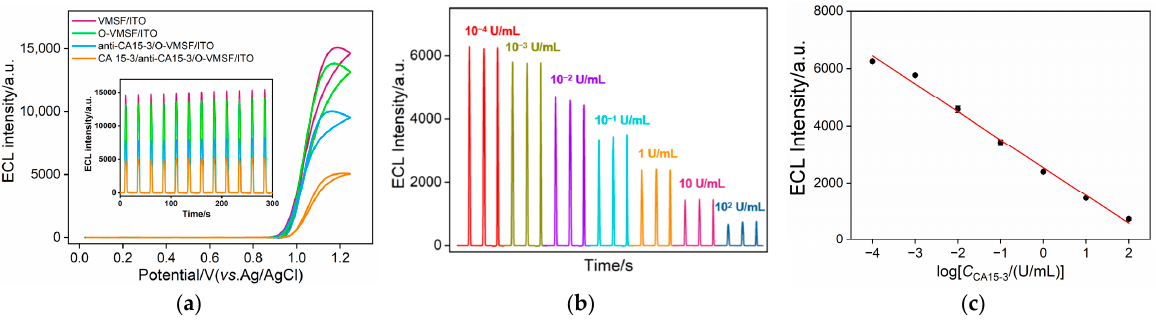
Figure 4. ( a ) IECL-potential curves of VMSF/ITO, O-VMSF/ITO, anti-CA 15-3/O-VMSF/ITO, and CA 15-3/anti-CA 15-3/O-VMSF/ITO in 10 µ M Ru(bpy)32+. The inset in ( a ) shows the corresponding IECL-time curves. ( b ) ECL responses of the immunosensor to various concentrations of CA 15-3 from 10 − 4 U/mL, 10 − 3 U/mL, 10 − 2 U/mL, 10 − 1 U/mL, 1 U/mL, 10 U/mL to 100 U/mL. ( c ) The corre- sponding calibration curve. The error bars represent the standard deviation of three measure- ments under the same condition.